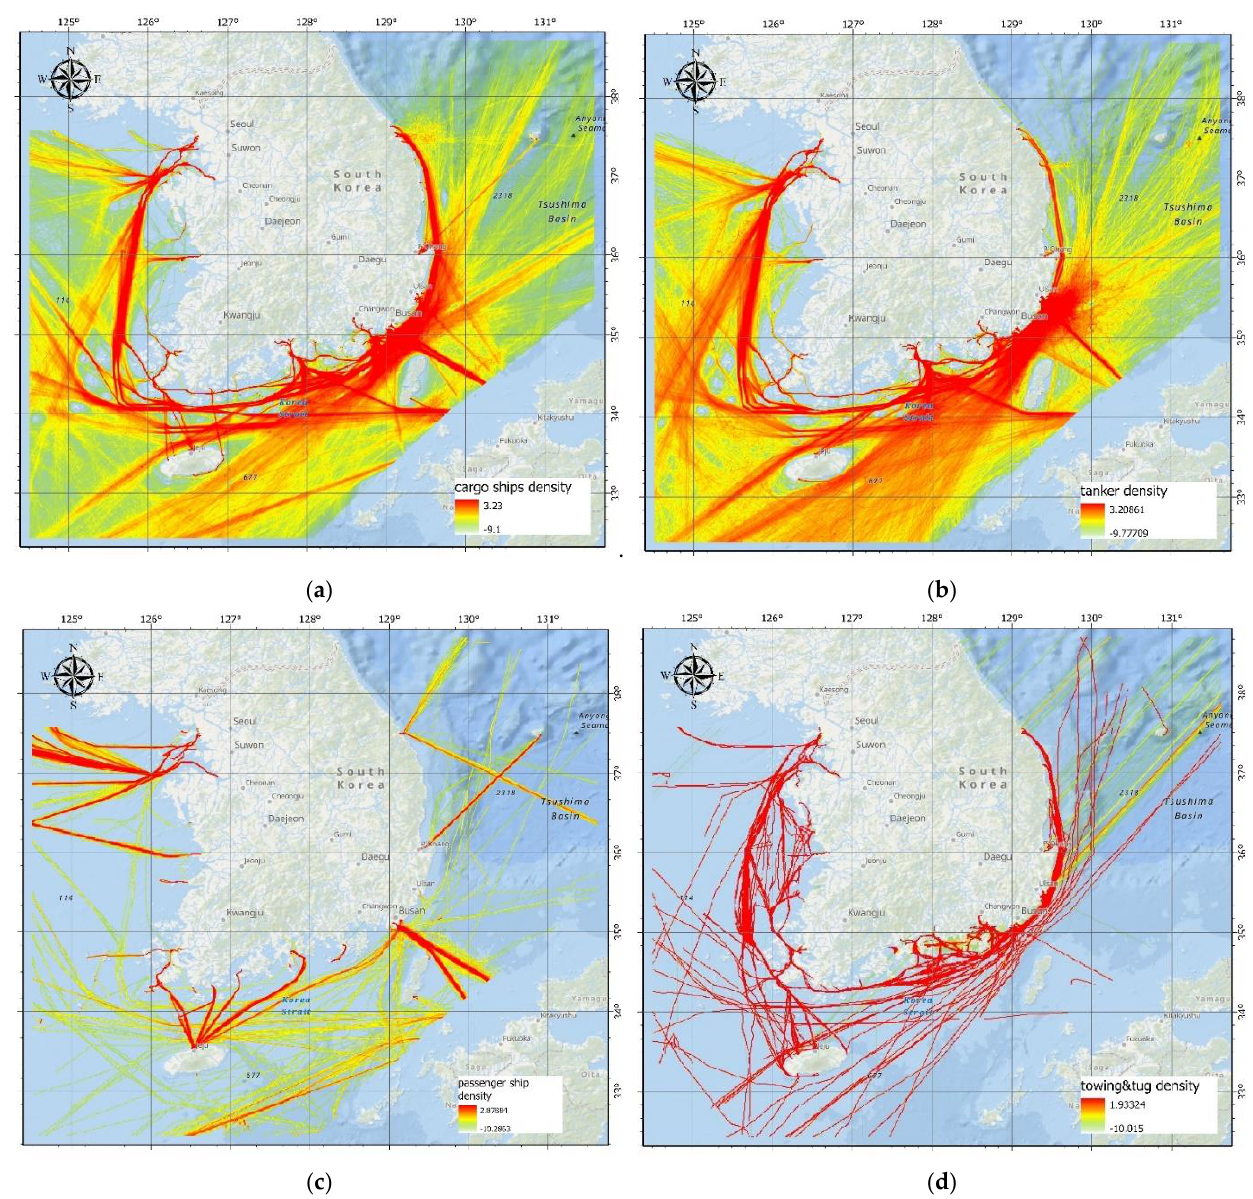
Figure 6. Visualization of log-transformed density values by ship type using standard-deviation- based stretch symbolization: ( a ) cargo ships, ( b ) tankers, ( c ) passenger ships, and ( d ) towing ships.